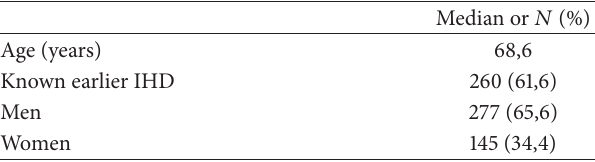
Table 3: Final diagnoses of the patients admitted at OUH ( 𝑛 = 354 ).